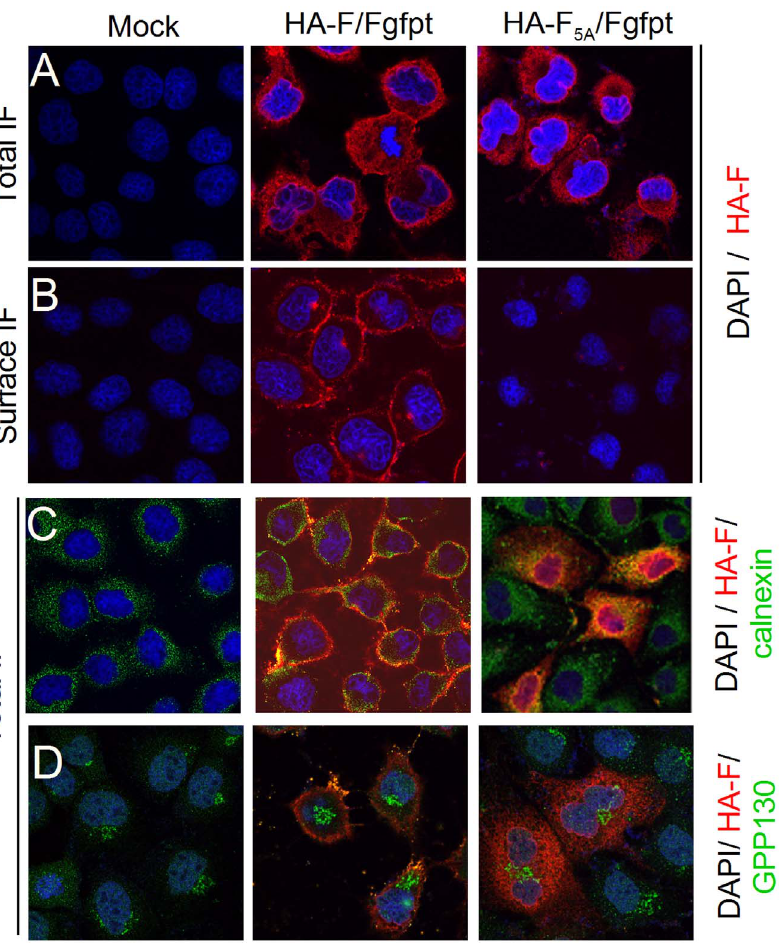
Figure 6. Subcellular localization of the wt-HA-F and HA-F 5A in the context of infections. MDCK cells constitutively expressing a -gfpt siRNA were grown on coverslips and infected with rSeV-HA-F/Fgfpt and rSeV-HA-F 5A mvpt/Fgfpt or kept mock infected. Twenty-four hours post infection, cells were submitted to ( A .) total immunofluorescence (Total IF) or ( B .) surface immunofluorescence (Surface IF) protocols. a -HA : primary antibody for both protocols. C . and D . as in ( A .), except, a -calnexin ( C .) or a -GPP130 ( D .) primary antibodies were added with a -HA. DAPI: nuclei staining. Merged channel images are presented for convenience. Separate channel images for C are presented in figure S4.